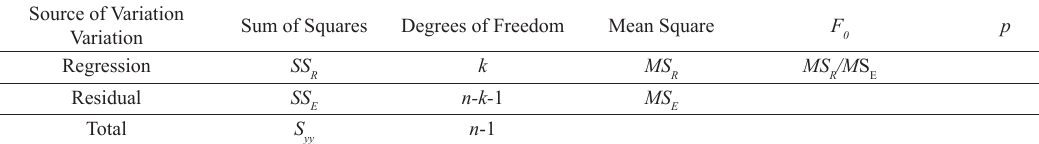
Table 1. Analysis of the Variance for Significance of